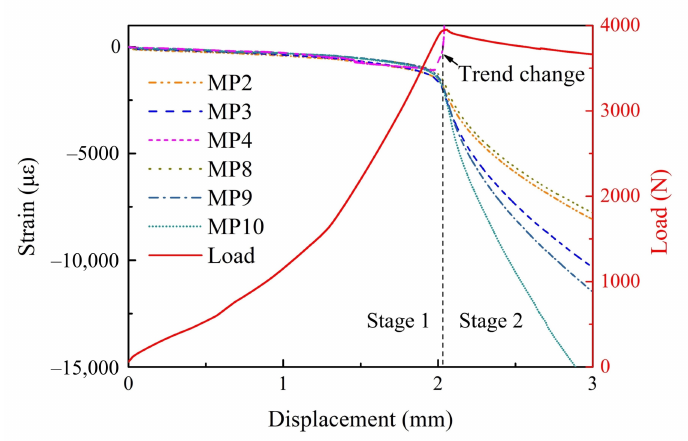
Figure 6. Characteristic comparison of the load–displacement curve and strain–displacement curves of multiple measuring points of sample